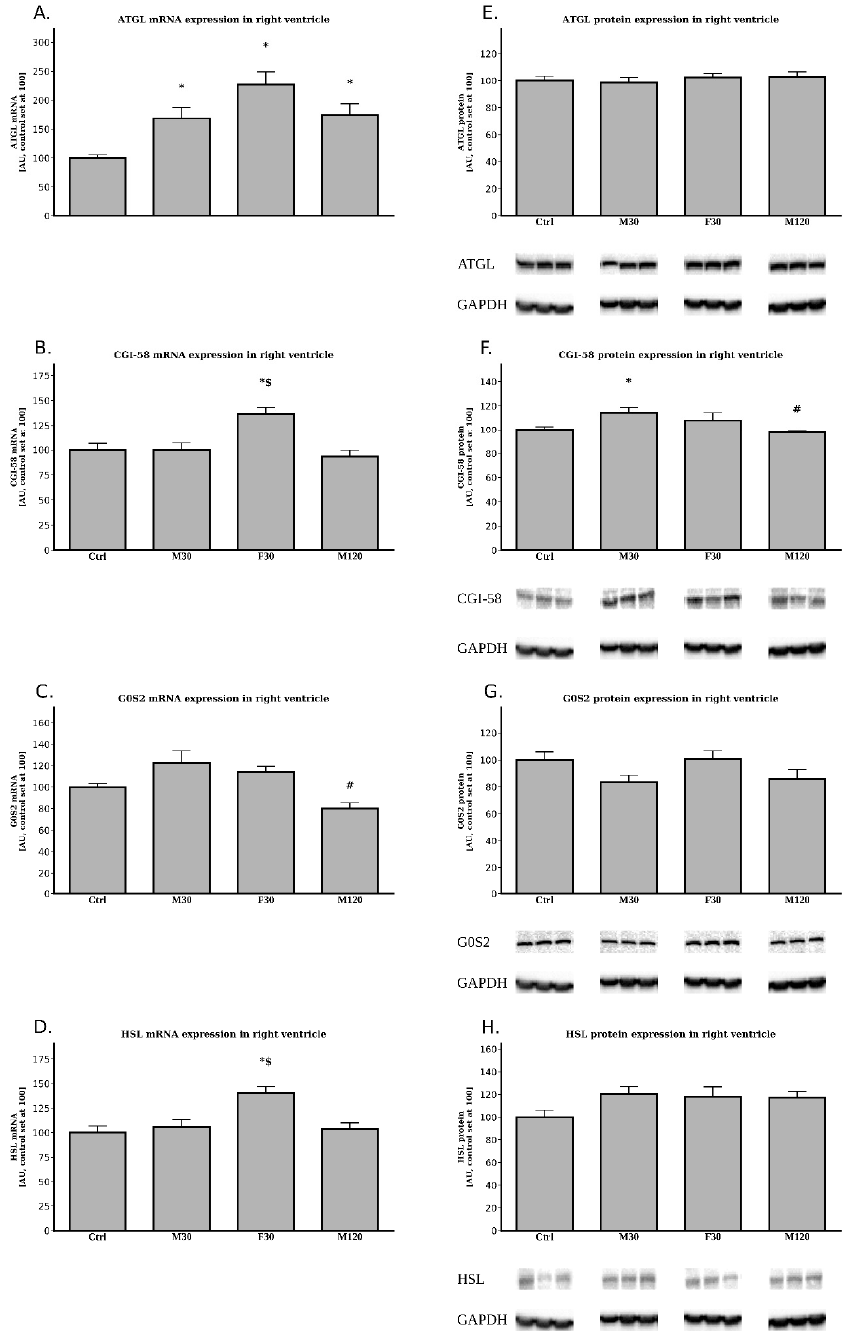
Figure 5. Effects of treadmill running on the mRNA and protein expressions of ATGL ( A , E ), CGI-58 ( B , F ), G0S2 ( C , G ), HSL ( D , H ) in the right ventricle. Data are expressed as mean ± SEM. For the sake of clarity, the control group was set at 100, and exercised groups were scaled with respect to Ctrl * p < 0.05 di ff erence vs. control (Ctrl); # p < 0.05 di ff erence M120 vs. M30; $ p < 0.05 di ff erence F30 vs.